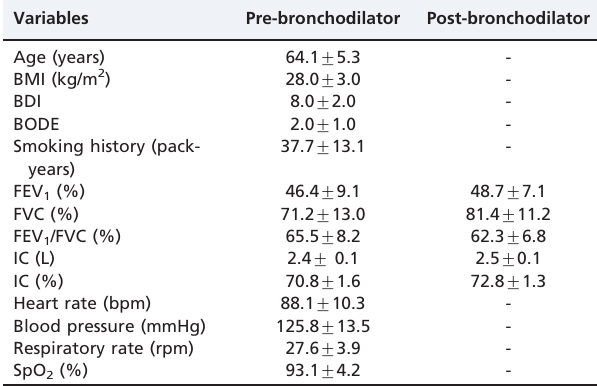
Table 1 - Anthropometric, pulmonary function, hemodynamic and respiratory baseline characteristics of the COPD patients in this